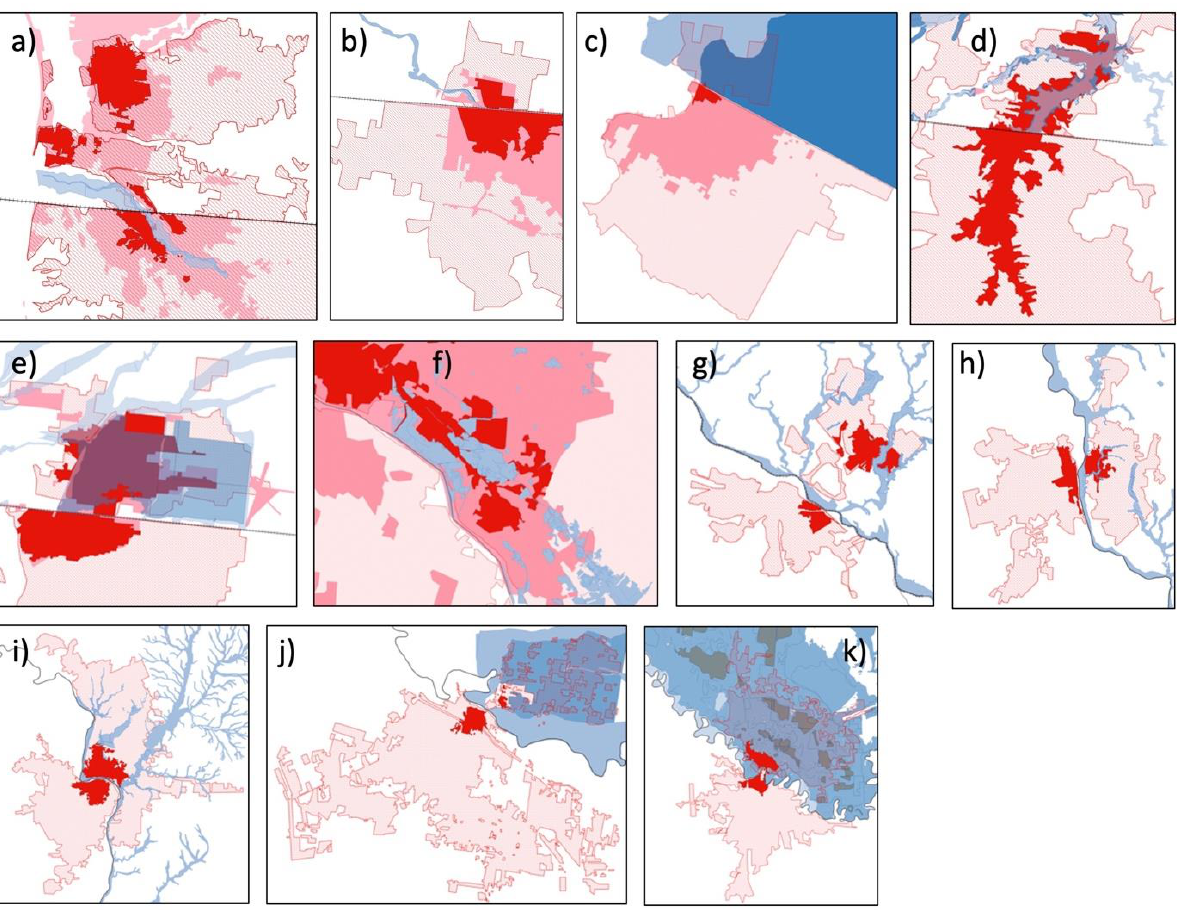
Figure 4. Flood zones (FEMA) on the US side; ( a ) San Diego area: Tijuana river, ( b ) Calexico: Rio Nuevo, ( c ) San Luis: Rio Colorado, ( d ) Nogales: Arroyo, ( e ) Douglas: Whitewater Draw, ( f ) El Paso: Rio Grande, ( g ) Del Rio: Rio Grande, ( h ) Eagle Pass: Rio Grande, ( i ) Laredo: Rio Grande, ( j ) Hidalgo: Rio Grande, ( k ) Brownsville: Rio Grande (data sources: Table A2).